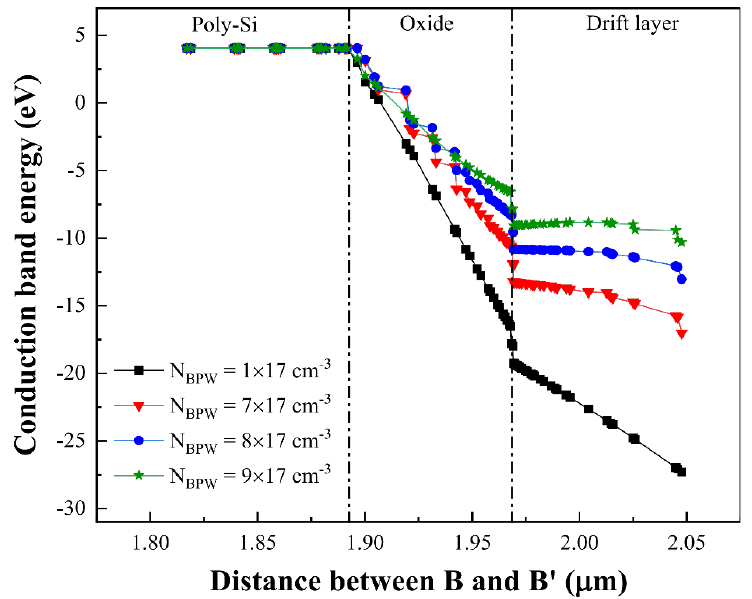
Figure 5. Conduction band edge energy profiles across the B-B’ section lines of the TMOSFET with N BPW of 1 × 10 17 cm − 3 , 7 × 10 17 cm − 3 , 8 × 10 17 cm − 3 , and 9 × 10 17 cm − 3 .